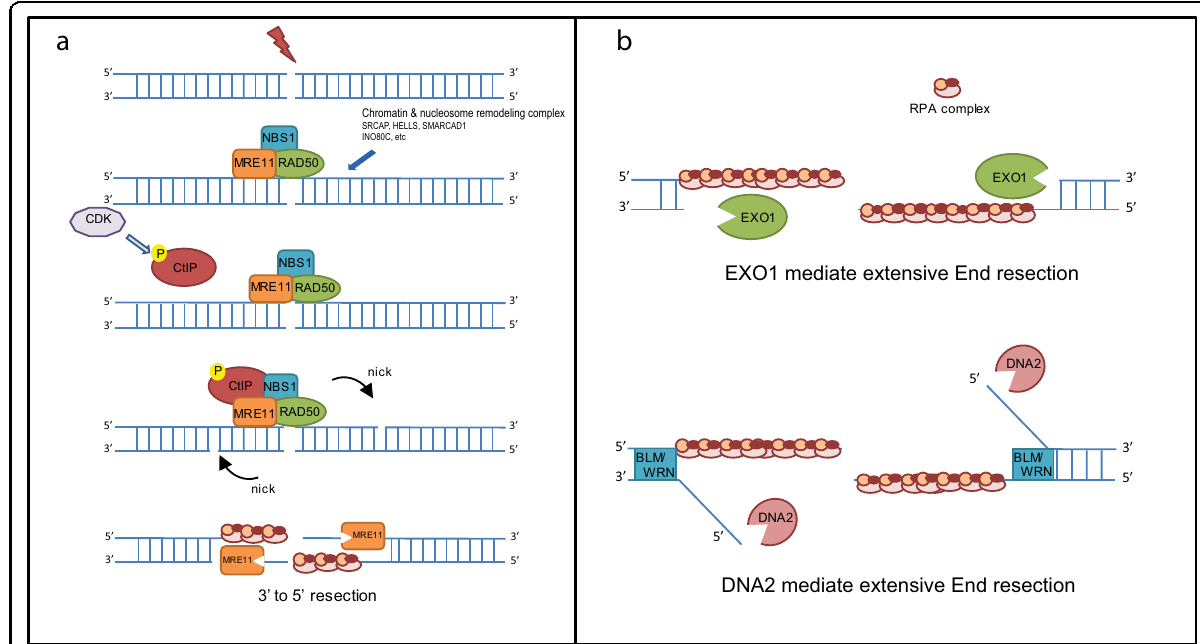
Fig. 1 Initiation and extension of DNA end resection. a The model of MRN-CtIP and chromatin/nucleosome remodeling proteins in the regulation of DNA end resection initiation. b The model of EXO1, DNA2, BLM, WRN and the RPA complex in the regulation of DNA end resection